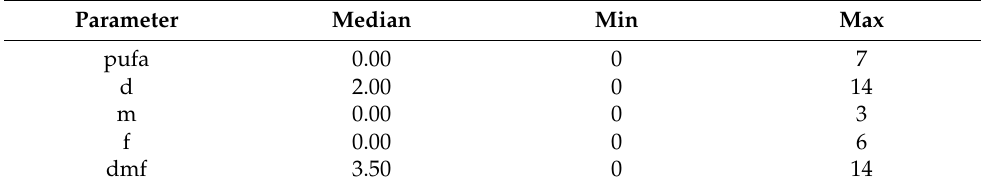
Table 3. Dental caries experience and pufa indices in the examined population. Parameter Median